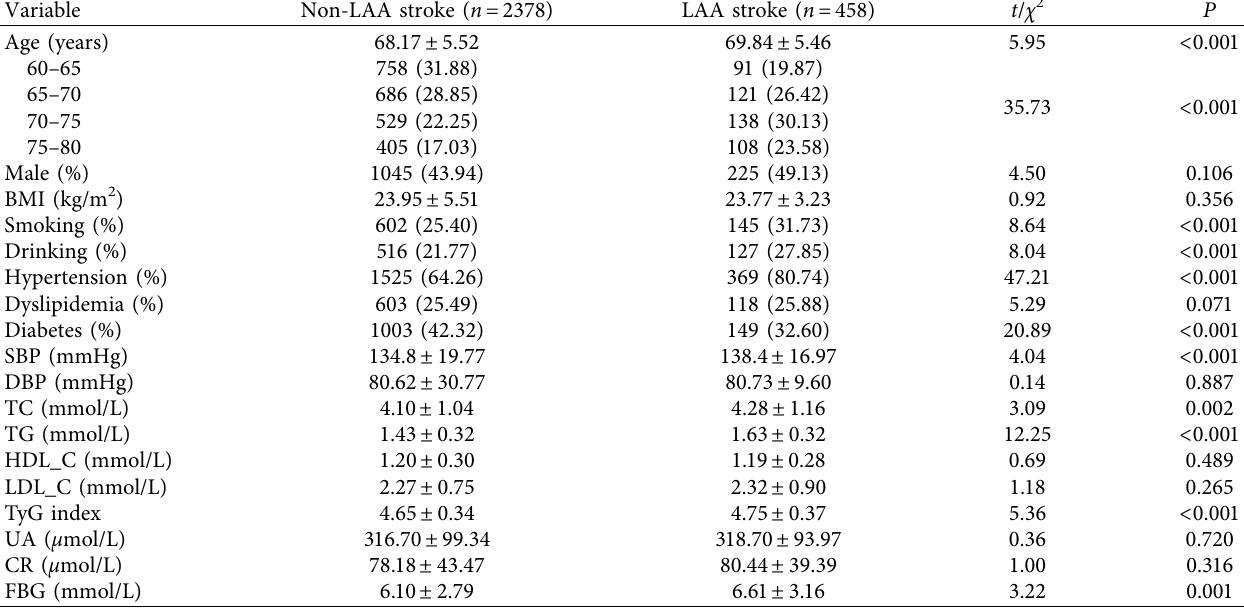
Table 1: Comparison of demographic characteristics and clinical parameters between the LAA stroke and non-LAA stroke groups.